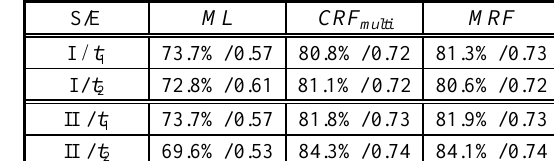
Figure 3. Overall accuracy of CRF-classification with different context models and varying scale λ max for the spatial interaction